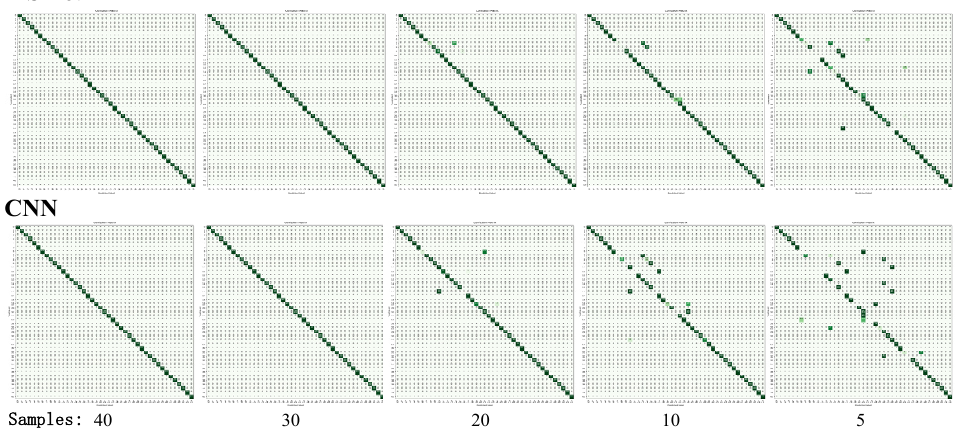
Figure 16. Comparison of confusion matrix of two methods with different numbers of training samples.